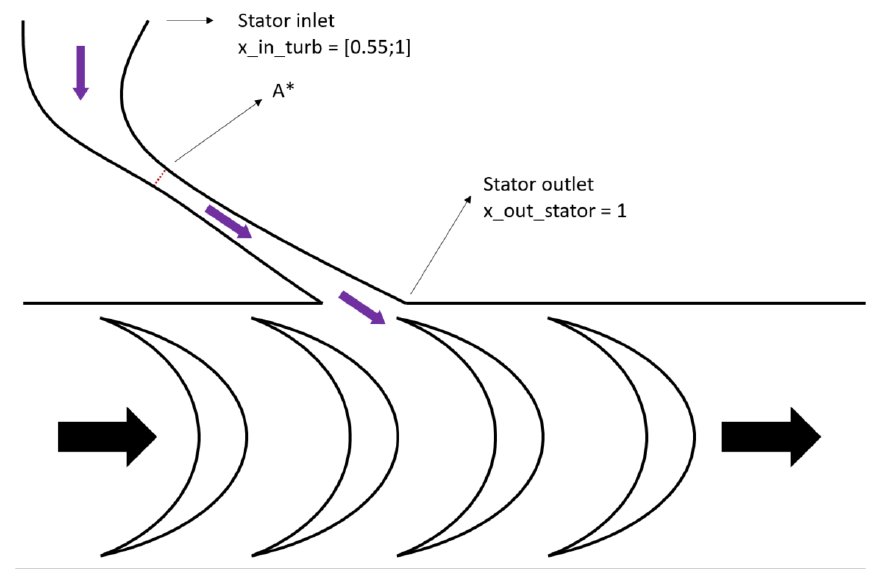
Figure 17. Simplified diagram of a partial admission micro axial turbine stator.